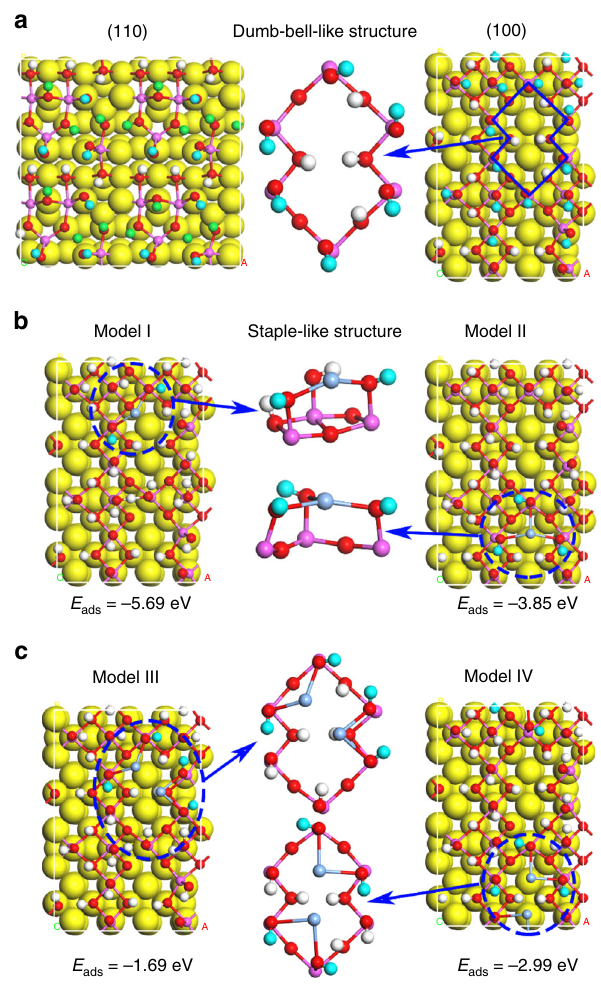
Fig. 5 DFT calculations on interaction between Ag species and hydroxyl groups. a Optimized periodic models of hydroxylation Al 2 O 3 (110) surface and Al 2 O 3 (100) surface; b Optimized periodic models (model I and model II) of the adsorption of Ag atom on (100) surface of Al 2 O 3 ; c Optimized periodic models (model III and model IV) of the adsorption of two Ag atoms on (100) surface of Al 2 O 3 . (pink: Al atom, red: O atom, blue: H atom in terminal hydroxyls (type I), green: H atom in doubly bridging hydroxyls (type II), white: H atom in triply bridging hydroxyls (type